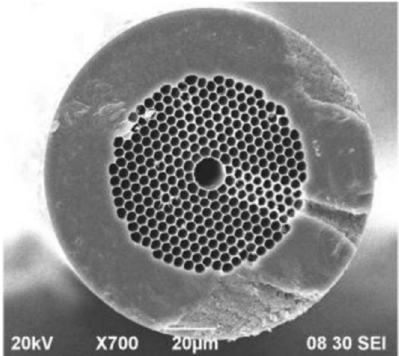
Figure 8. Scanning Electron Microscope image of a hollow-core fiber with a side microchannel. Reprinted from [45].